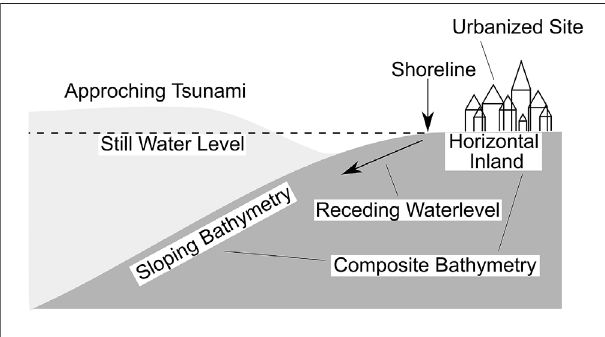
FIGURE 1 | Conceptual sketch of a tsunami wave propagating on a sloped bathymetry while approaching the shore. The inland topography is approximately horizontal (composite bathymetry). The still water line is indicated by a dashed line. Note that a tsunami not necessarily consists of a leading trough, as shown here, when approaching the shore (Fritz et al.,